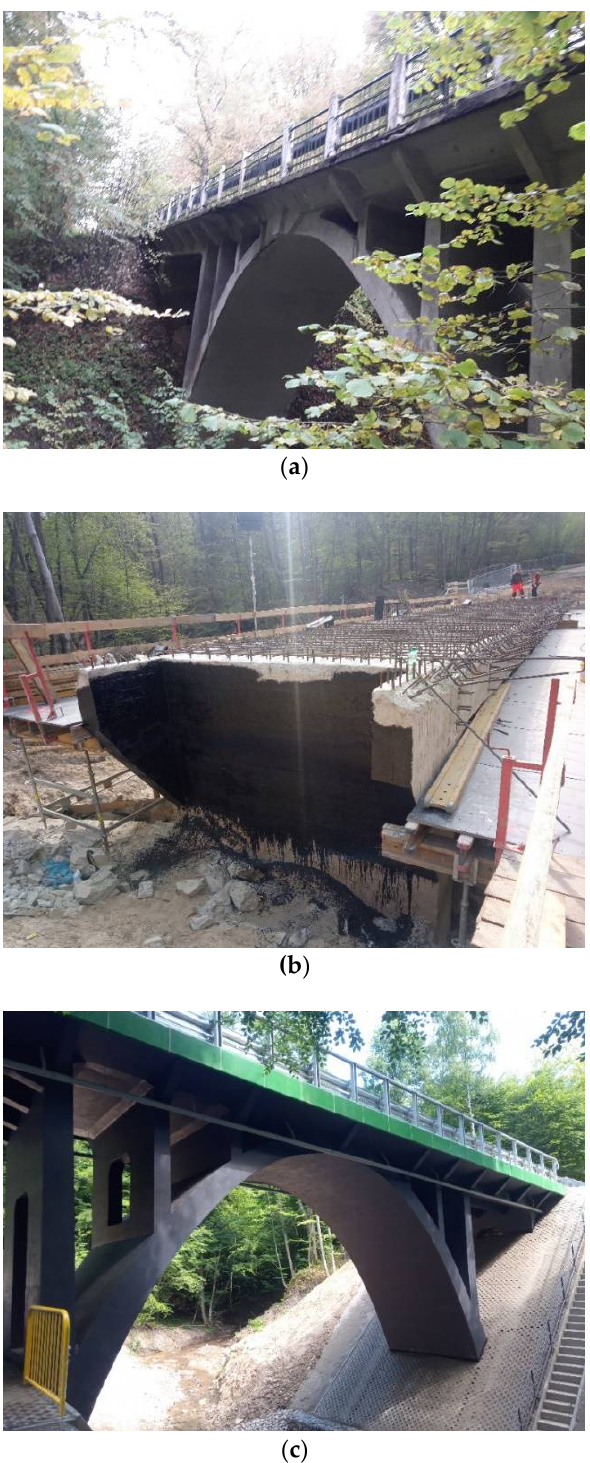
Figure 2. Jagodnik arch bridge: ( a ) Before; ( b ) during; and ( c ) after reconstruction. The concrete cylinders were tested in compression to the failure according to EN 12390- 3 standard [33]. Concrete dry density was determined according to method guidelines in EN 12390-7 standard [34], after drying the specimens in a ventilated oven (T = 105 ± 5 ◦